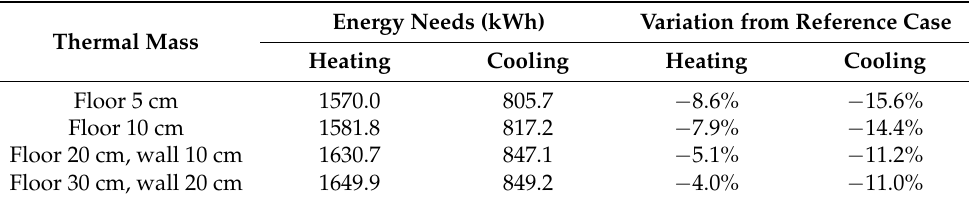
Table 7. Building’s annual energy needs and percentage change relative to the reference case varying the heat storage mass.